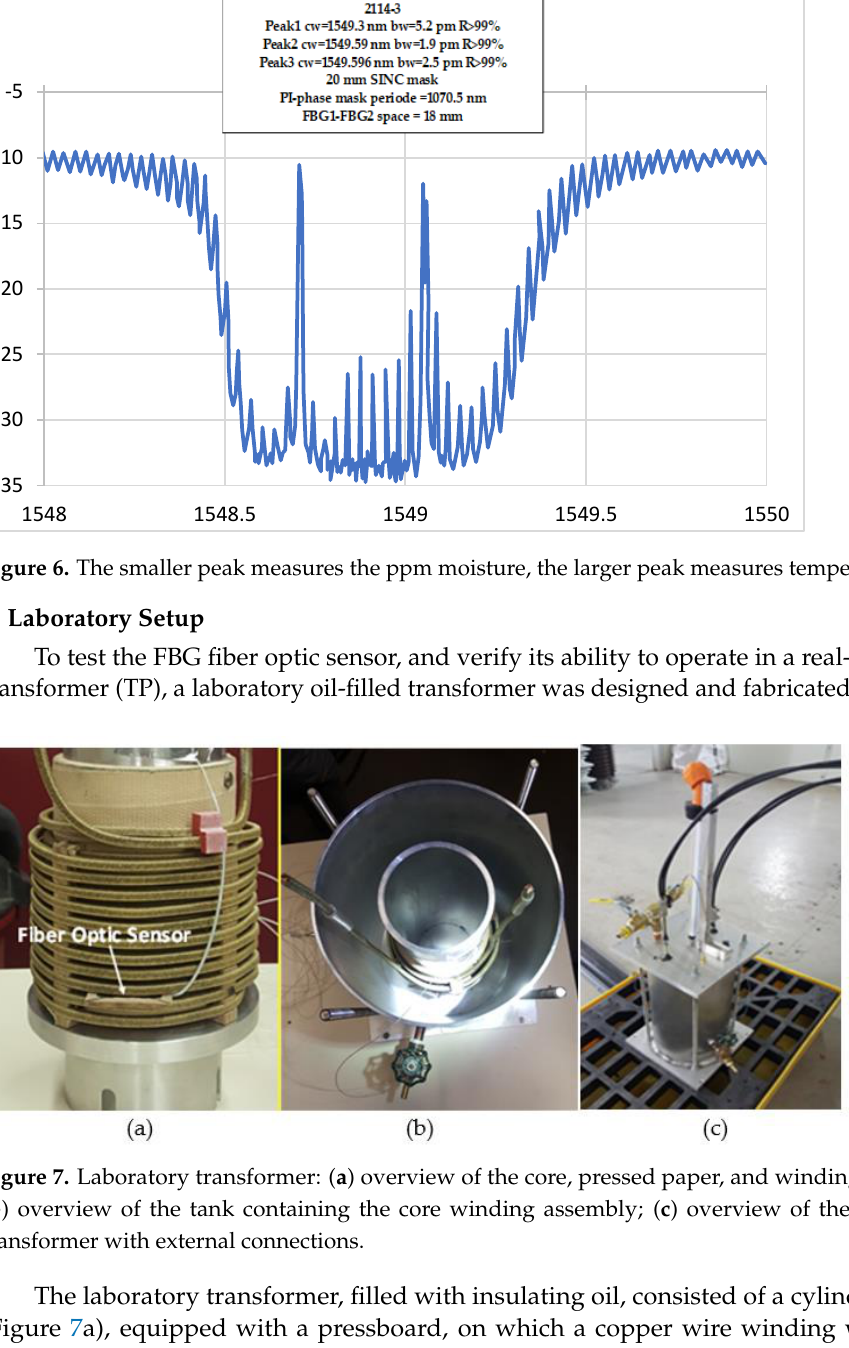
Figure 8. Core and winding assembly, in the vacuum drying oven. Figure 9. Experimental transformer connection to the high current source. (A) High current source CIGELE-S5000A, (B) Connection cables, (C) Laboratory transformer.